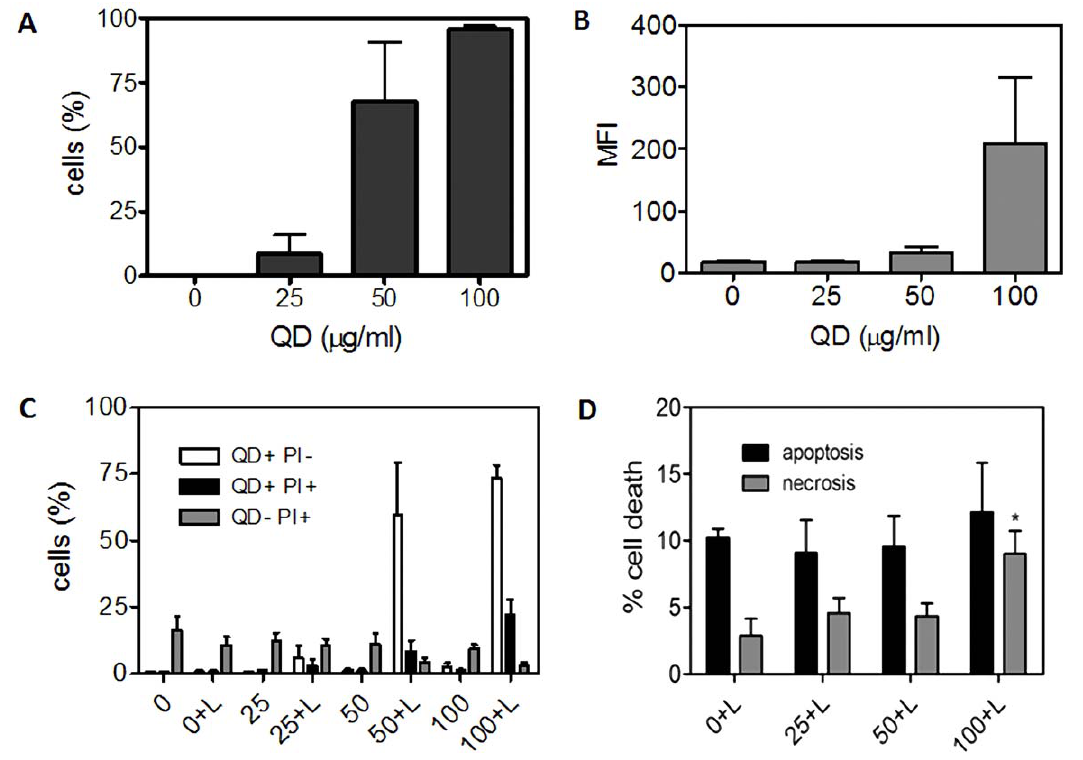
Figure 5. Characterization of QDs incorporation into MKN45 cells by flow cytometry. A, Per cent of cells incorporating QDs. B, MFI represent the amount of QDs incorporated after incubation with 25, 50 and 100 m g/ml QDs in the presence of lipofectamine. C, Viability of MKN45 cells incubated with QDs with or without lipofectamine. The total population of cells (QD + PI 2 , QD + PI + and QD 2 PI + ) is referred to as 100%. Numbers indicate concentrations ( m g/ml) and L stands for lipofectamine. D, Characterization of cell death in MKN45 cells incubated with QDs plus lipofectamine. 100% stands for the total population of QD + cells.